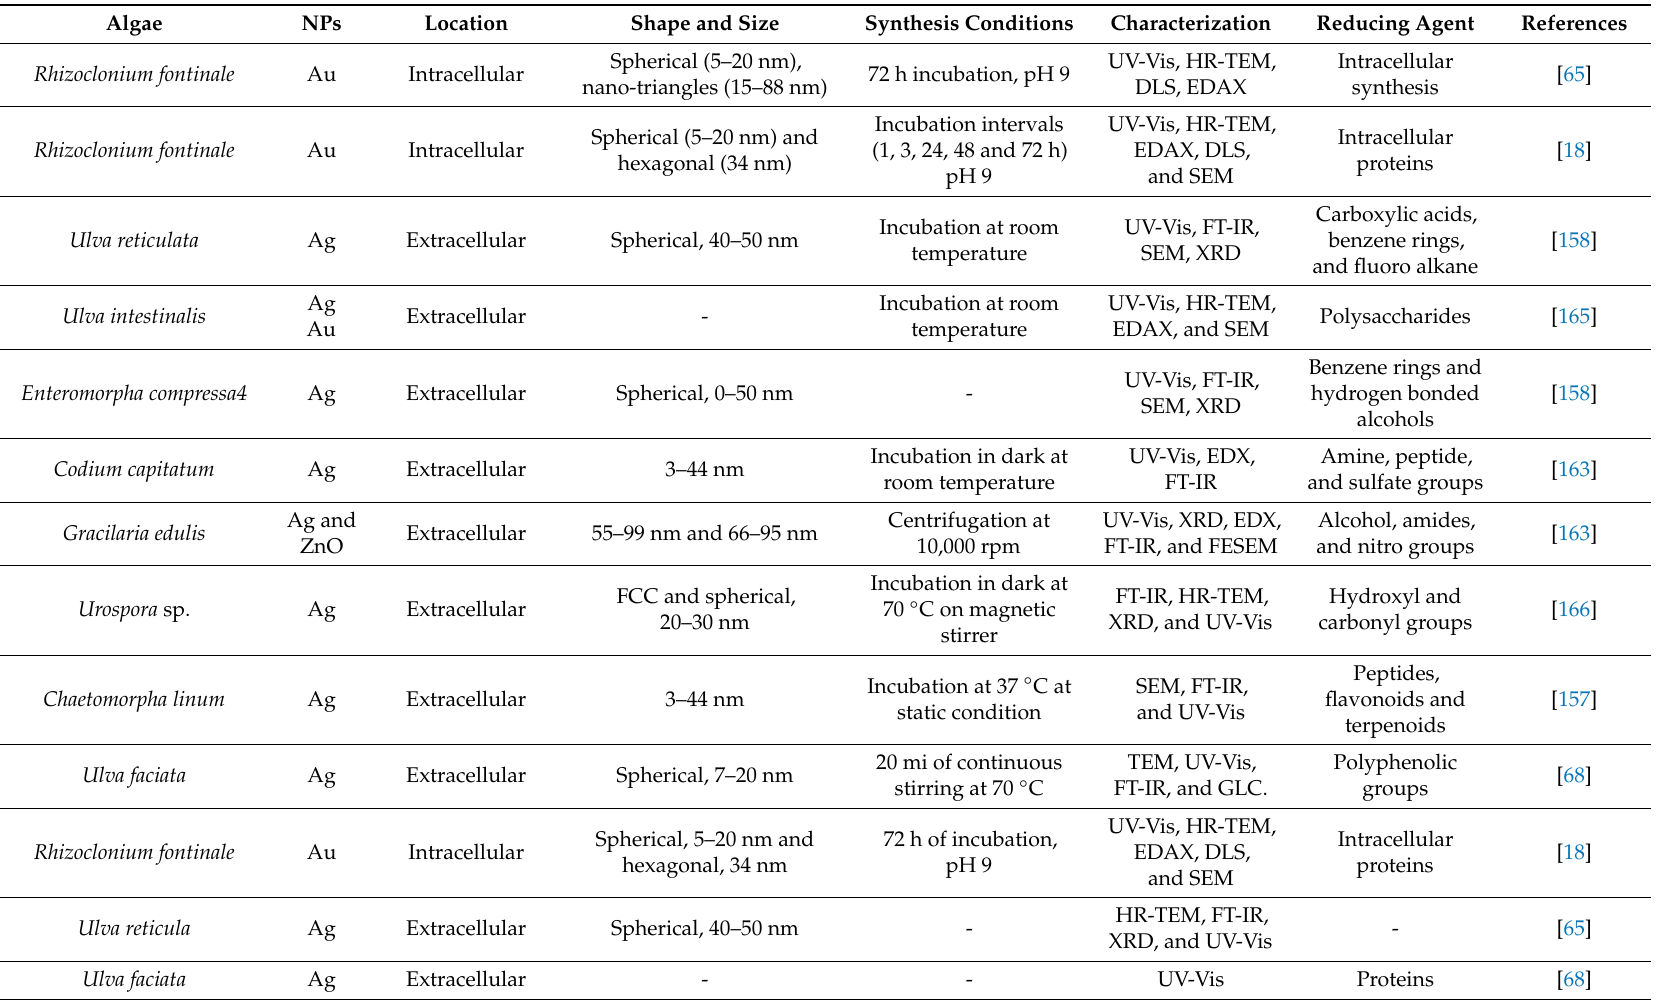
Table 5. Macro green algae-mediated biosynthesis of Metallic